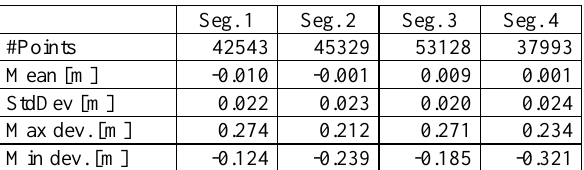
Table 2. Statistics of differences between UAS and TLS for